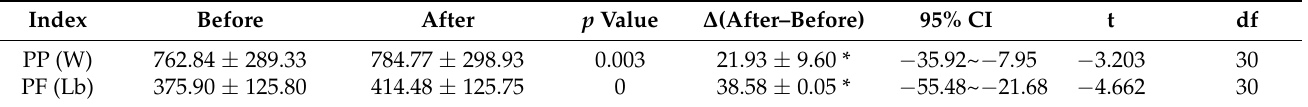
Figure 3. ( a ) The comparison of peak force in each phase between the 0 ◦ C and − 5 ◦ C groups. ( b ) The comparison of peak power in each phase between the 0 ◦ C and − 5 ◦ C groups. Note: * means that there are significant differences between Before and After in peak force in the 0 ◦ C group. The “a” means that there are significant differences between Before and After in peak force in the − 5 ◦ C group. Moreover, the “b” means that there are significant differences between Before and After in peak power in the 0 ◦ C group. Table 2. The information on PP and PF between before and after 0 ◦ C cryotherapy (mean ± SD).